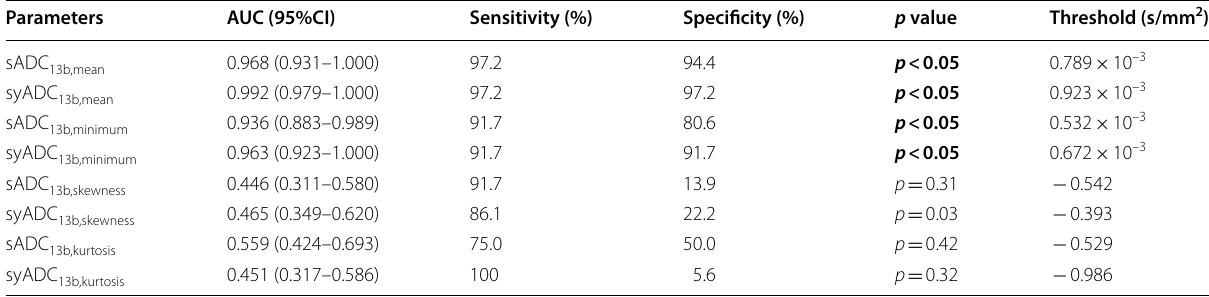
Table 4 Diagnosis performance on cervical cancer of histogram-derived scanned and synthetic 13b-protocol ADC values with a b value of 0 and 1500 s/mm 2